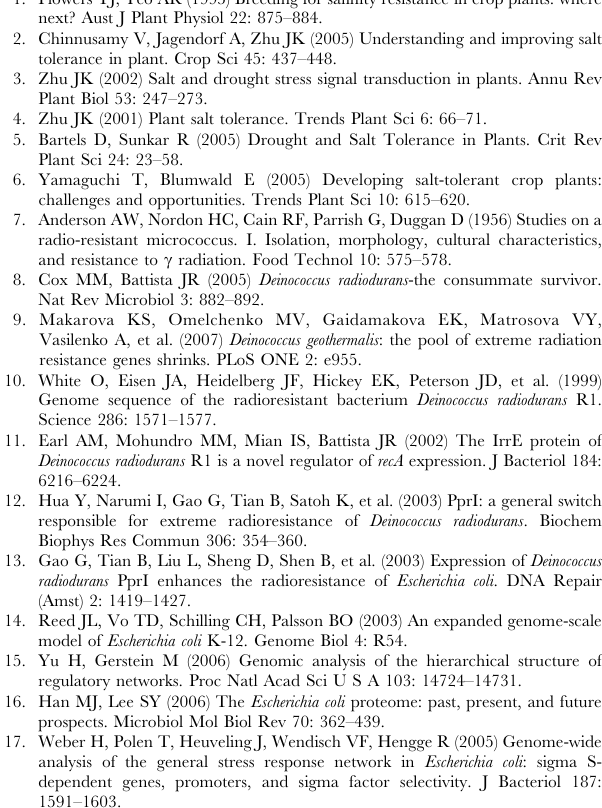
Table S3 Primers used for qRT-PCR amplifications in this study Found at: doi:10.1371/journal.pone.0004422.s003 (0.04